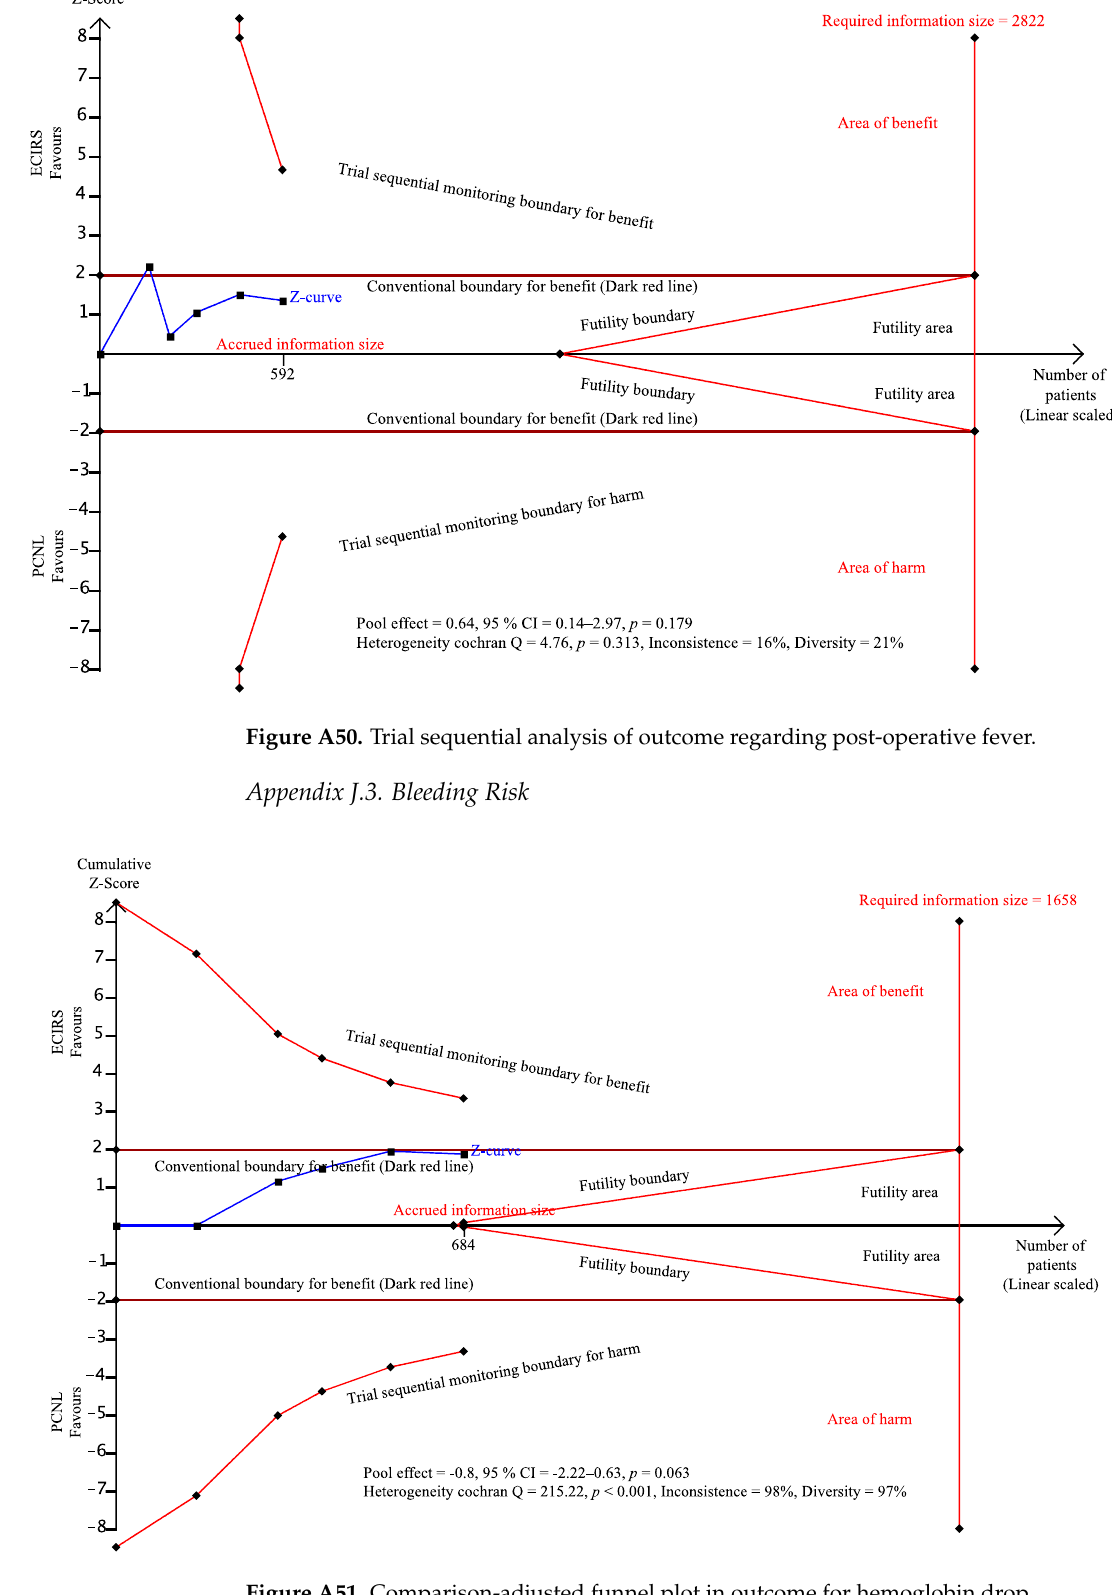
Figure A52. Trial sequential analysis of outcome regarding required blood transfusion.